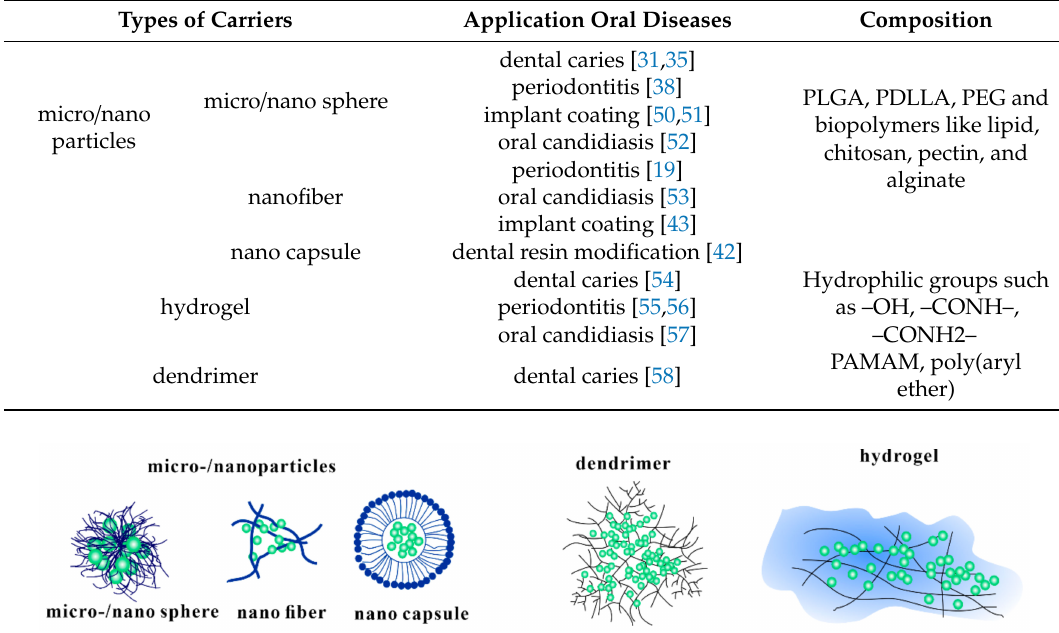
Table 1. Carriers of drug delivery systems(DDS) and the application in oral infectious diseases.